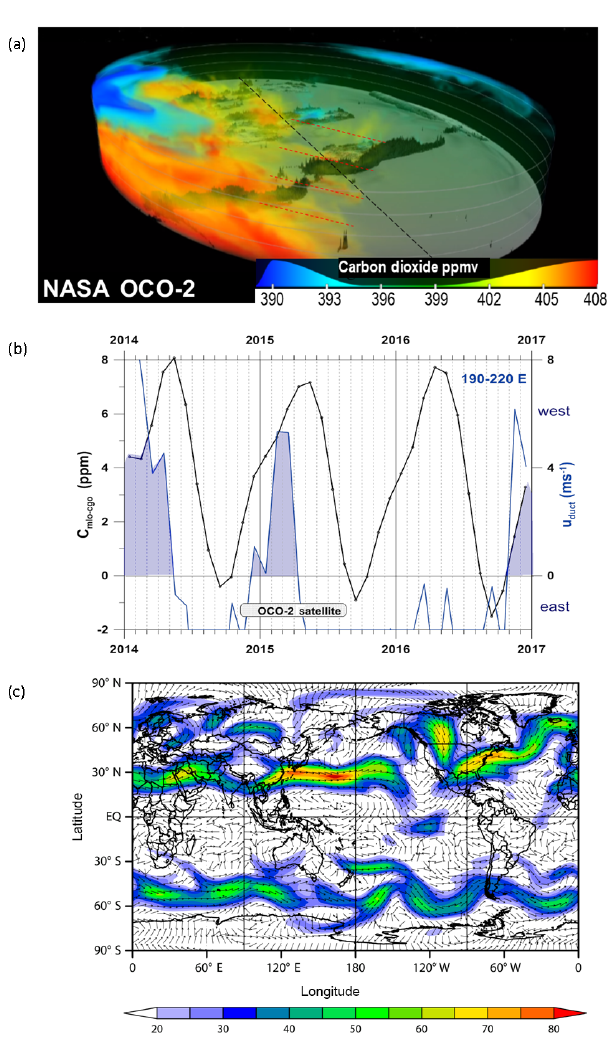
Figure 1. (a) OCO-2 image for 17 February 2015 showing Rossby wave dispersion (dashed red lines) in CO 2 concentration across the Equator (dotted black line). (b) Seasonal cycle of C mlo − cgo and u duct , with area where both are positive shaded, for 1 January 2014 to 31 December 2016, and (c) 300hPa wind vector directions and wind strength (ms − 1 ) on 17 February